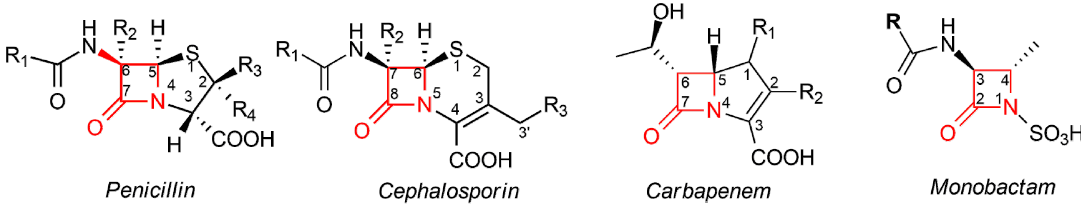
Figure 1. Core structures of different classes of β -lactam antibiotics. In penicillins, the β -lactam moiety is fused to a five-member thiazolidine ring; in cephalosporins, the β -lactam moiety is fused to a six-member dihydrothiazine ring; in carbapenems, the β -lactam moiety is fused to a pyrroline ring; in monobactams, the β -lactam ring is not fused to any other ring. In all classes, the β -lactam moiety is highlighted in red; the standard numbering of the nucleus for each class is also reported.